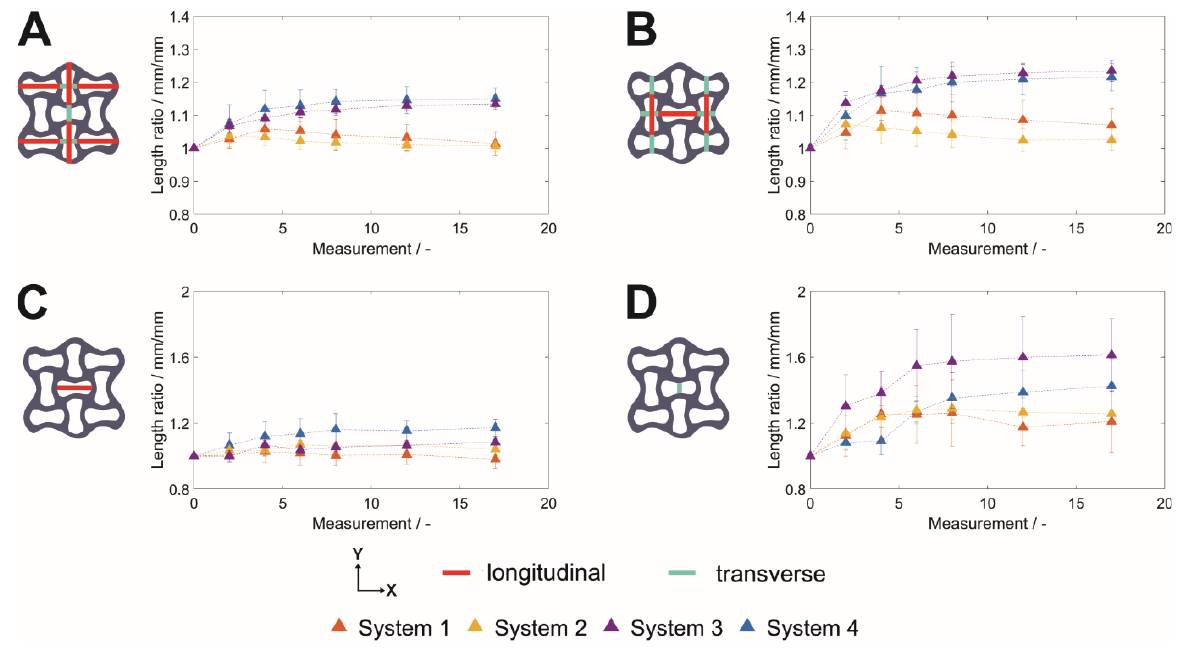
Figure 5. Time-dependent length of structural elements of the auxetic lattice consisting of nine point-symmetrically arranged unit cells. ( A ) Two longitudinal unit cells and one transverse unit cell, ( B ) one longitudinal and two transverse unit cells, and the ( C ) longitudinal as well as ( D ) transverse dimension of the center unit cell. The distances are highlighted in the corresponding exemplary structure. Data are expressed as the mean ± empirical standard deviation of two hydrogel speci- mens relative to the value at t 0 with one ( C + D ) or three lines per sample ( A + B ), with two samples per